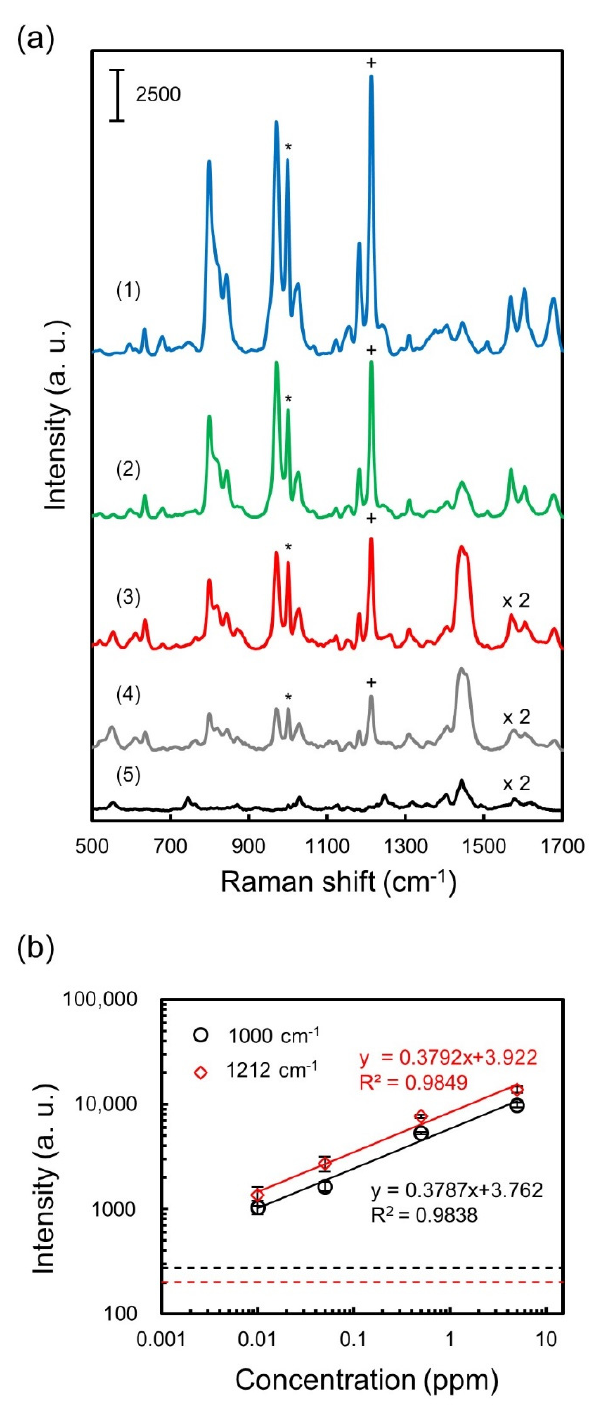
Figure 4. Simultaneous SERS detection of MC and 4-MMC in water. ( a ) SERS spectra of mixtures of MC and 4-MMC. The concentration of both MC and 4-MMC was 5, 0.5, 0.05, 0.01, and 0 ppm for the SERS spectrum (1), (2), (3), (4), and (5), respectively. The characteristic Raman peak of MC at 1000 cm − 1 and the characteristic Raman peak of 4-MMC at 1212 cm − 1 are marked with “*” and “+”, respectively. ( b ) A plot of the intensity of the 1000 cm − 1 peak versus MC concentration and the intensity of the 1212 cm − 1 peak versus 4-MMC concentration. Error bars show standard deviations with n = 30. The straight lines are the linear regression lines, and the black and red dotted lines indicate mean plus 3 σ of the 1000 and the 1212 cm − 1 peak, respectively, of the blank sample.